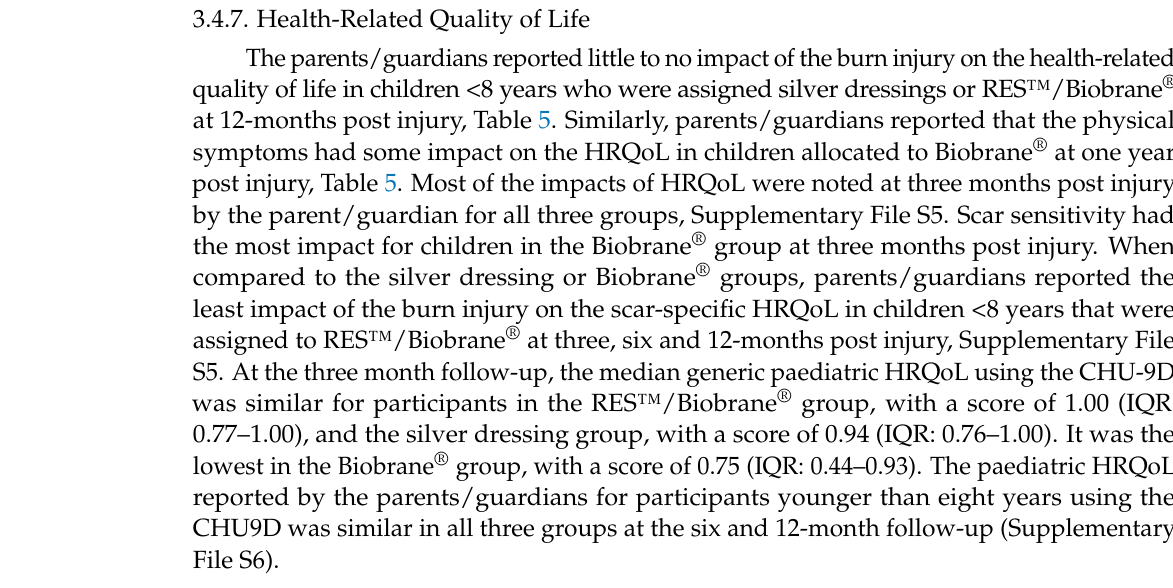
Table 5. Long-term secondary outcomes at secondary end point, 12-months post burn injury, as reported by a